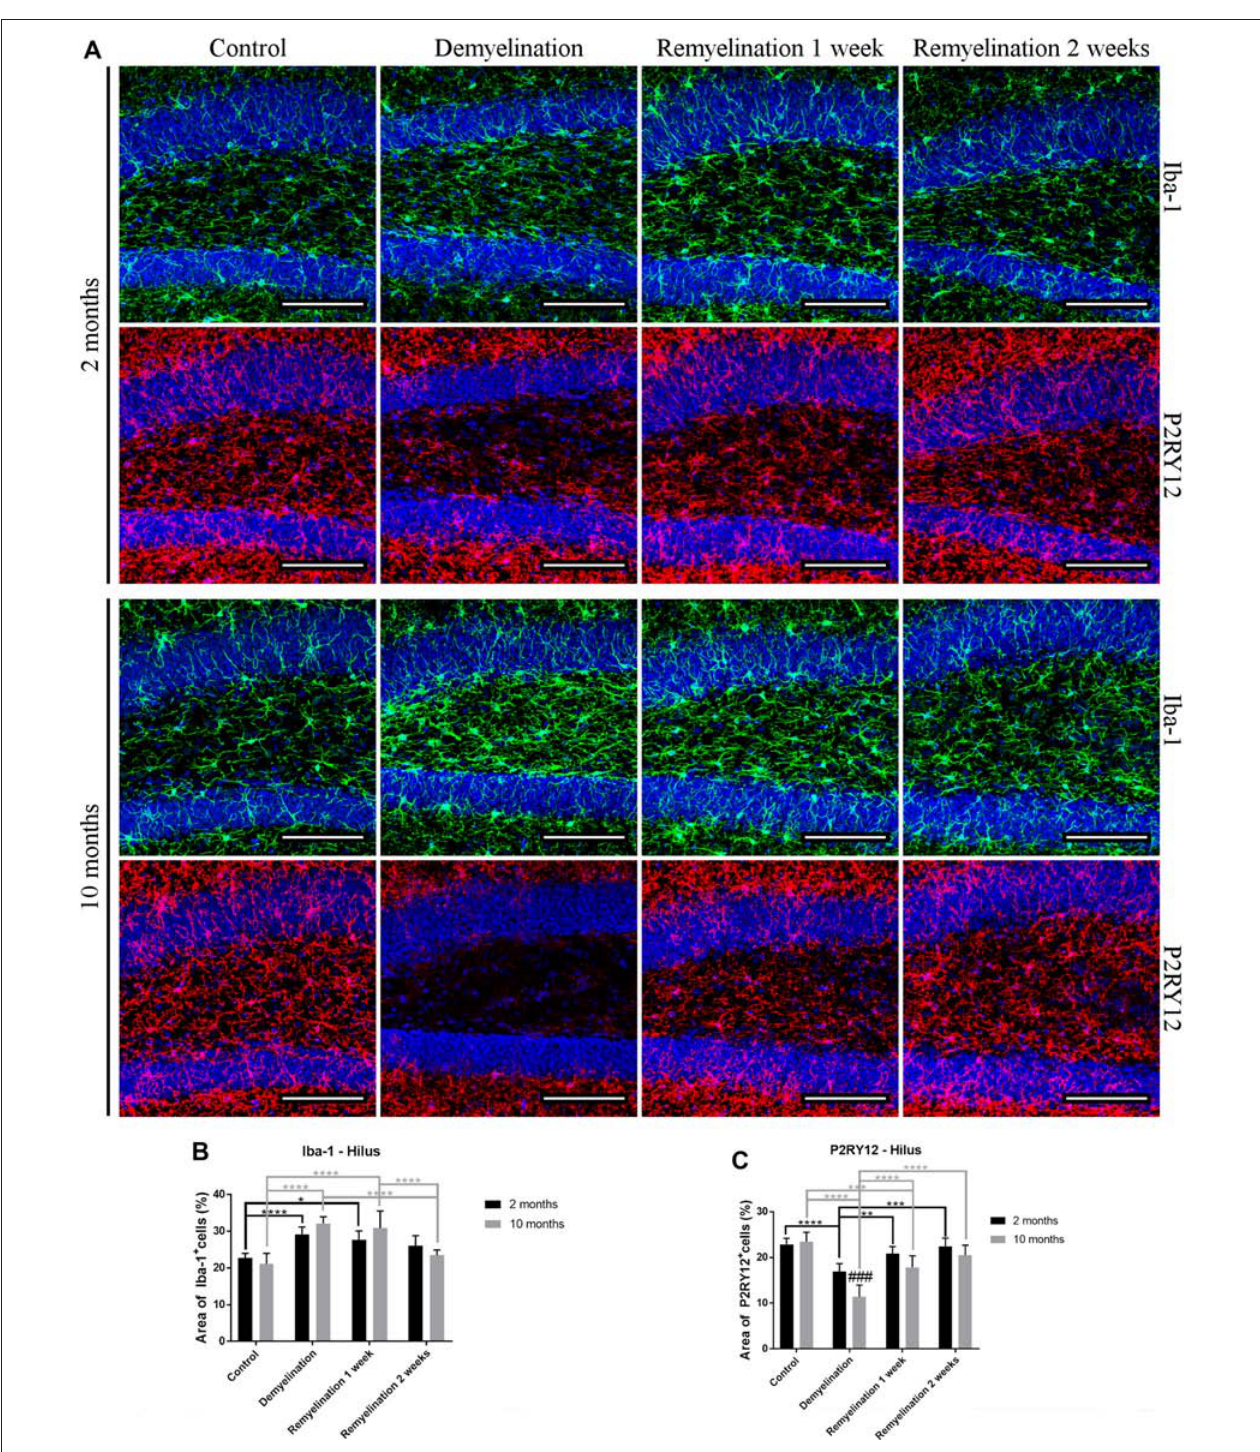
FIGURE 2 | Different patterns of ionized calcium binding adaptor molecule 1 (Iba-1), and P2RY12 during de- and remyelination in the hilus of the DG. (A) Iba-1 (green) and P2RY12 (red) labeling. Cell nuclei are stained with 4 (cid:48) ,6-diamidino-2-phenylindole dihydrochloride (DAPI; blue). (B) In both age groups, Iba-1 staining was significantly increased during demyelination until the first week of remyelination. (C) P2RY12 labeling was significantly decreased in both age groups during demyelination, and this was more pronounced and longer lasting in the middle-aged animals. Values are shown as means + SD ( n = 6 per group). Statistical significance was evaluated using a two-way ANOVA and a Tukey’s post hoc test. The p -values are indicated in the graphs: treatment effects within the same age group: ∗ p < 0.05, ∗∗ p < 0.01, ∗∗∗ p < 0.001 and ∗∗∗∗ p < 0.0001, age-related differences: ### p < 0.001. Bars: (A) 100 µ m.